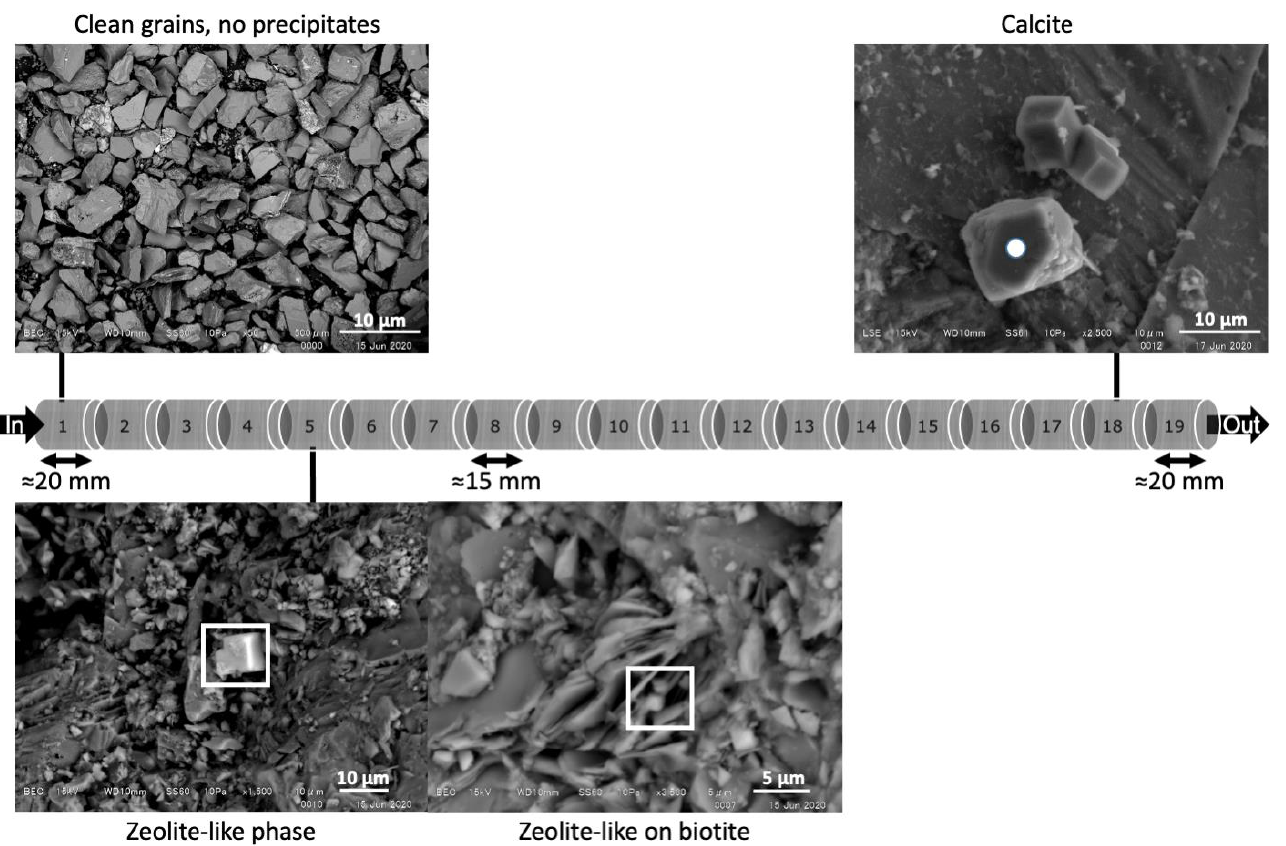
Figure 8. Summary of the mineralogy of the Toki granite with OPC leachates, and then MGW (Col-3). SEM photos are BSE images apart from the image from Section 18, which is an SE image. The white shapes in the SEM images indicate the areas used for SEM–EDS analysis (see Figure S5b–d).